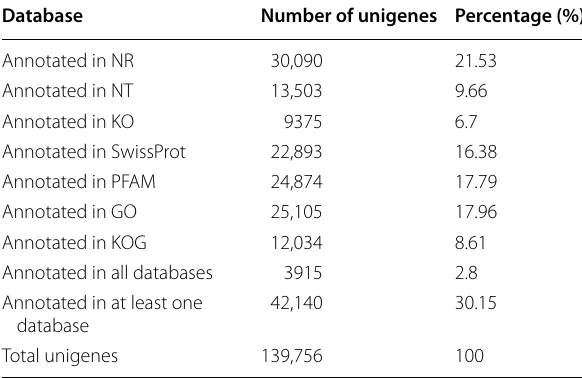
Table 1 Annotation result statistics between